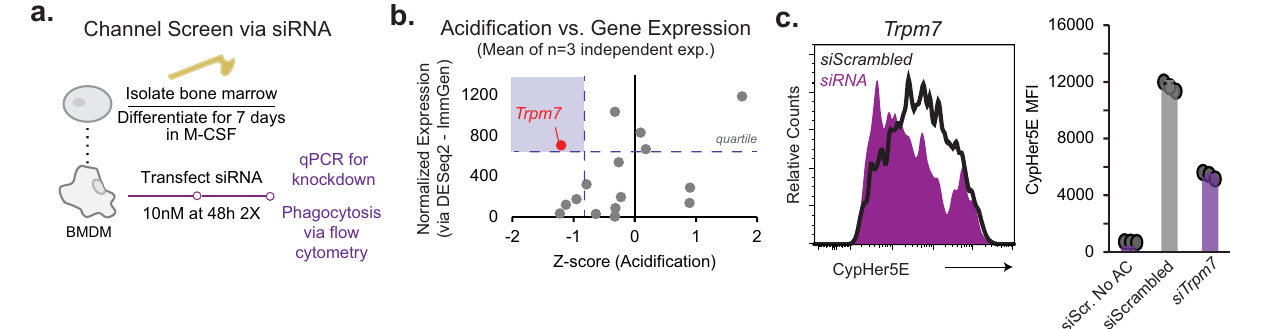
Fig. 2 Identi fi cation of the ion channel TRPM7 as a regulator of phagosome acidi fi cation. a Schematic showing the siRNA knockdown of candidate calcium channels in BMDMs. b Scatter plot showing the relationship between macrophage gene expression and relative effect on phagosomal acidi fi cation, depicted as mean Z-scores ( n = 3) from siRNA channel screen; target genes are depicted by single point; derivation of Z-scores is described in Methods . Gene expression value is average expression level across four macrophage subsets (ImmGen). Gray box denotes quartile for highest gene expression and the most negative effect on the z-score of acidi fi cation. c Left panel shows overlaid histograms of acidi fi cation (CypHer5E fl uorescence) in the Trpm7 knockdown ( siTrpm7 , purple) and control ( siScrambled , black) cells. Right panel shows Mean CypHer5E mean fl uorescent intensity (MFI) of CypHer5E.